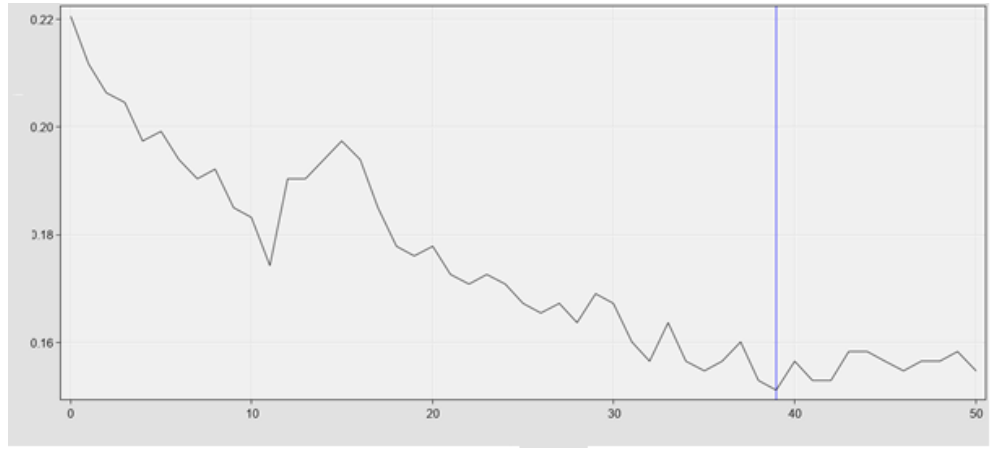
Figure 5. Neural network—iterations history (misclassification rate—training sample).